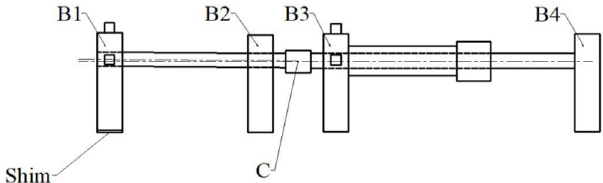
Fig. 4. The schematic diagram of coupling angle misalignment.